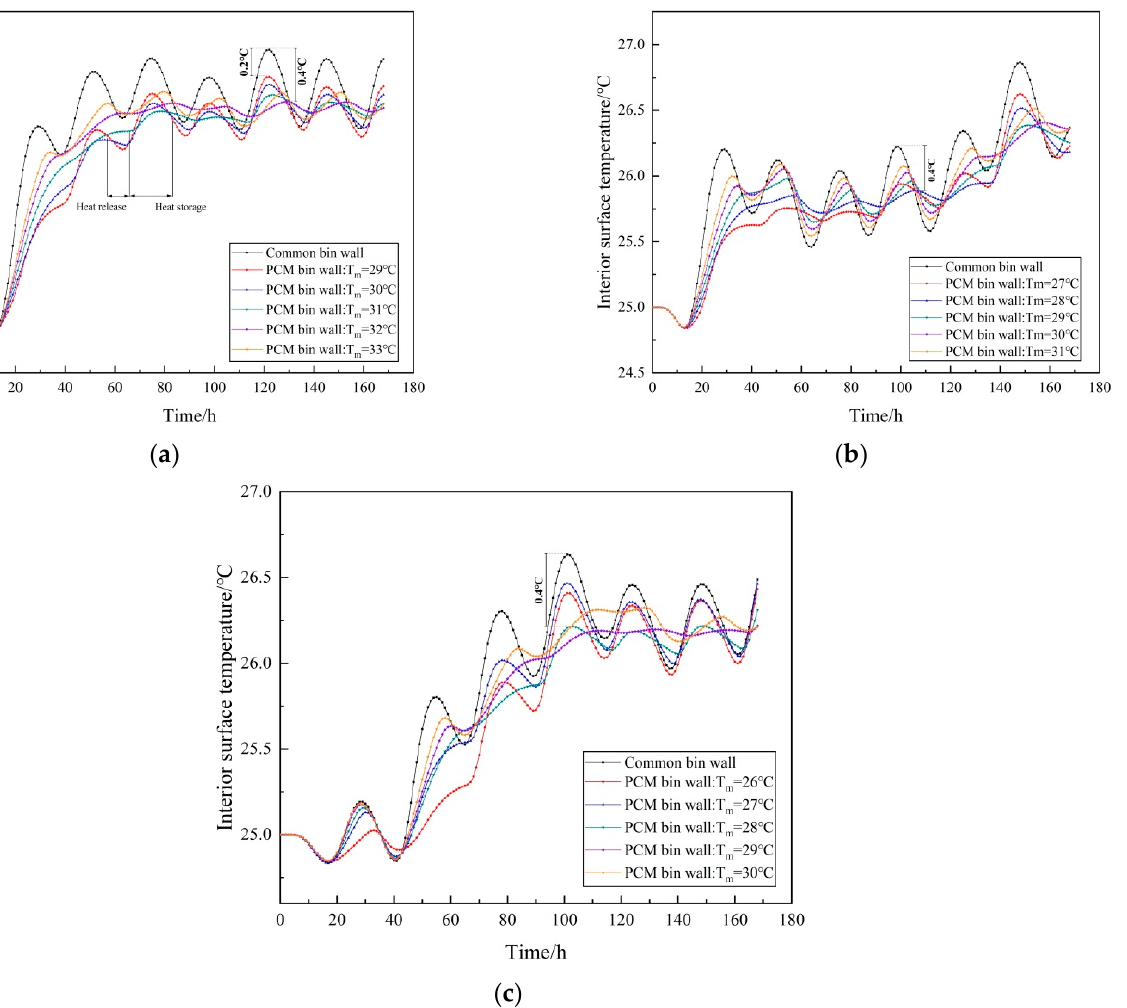
Figure 8. The T in distribution with different phase change temperatures. ( a ) Guangzhou. ( b ) Zhengzhou. ( c ) Harbin.